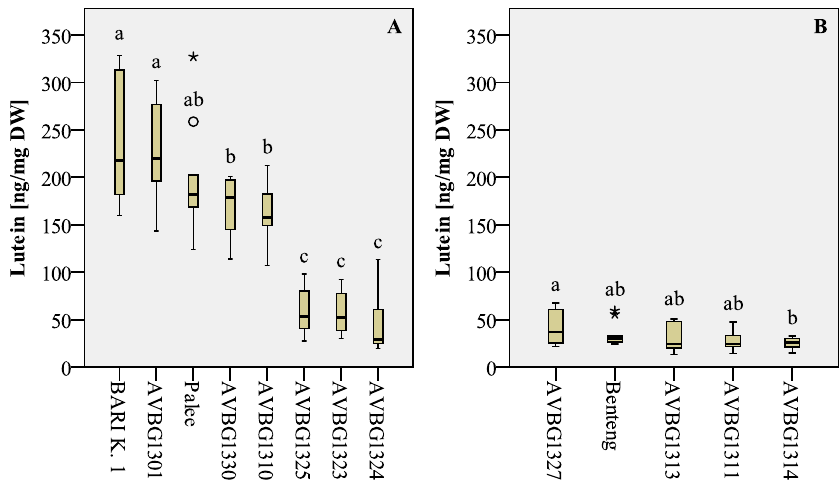
Fig. 5: Lutein contents in eight South Asian type (A) and five Southeast Asian (B) type bitter gourd entries cultivated in a greenhouse in Karlsruhe, Germany. Plots with same letters are not significantly different (P > 0.05). Stars stand for extreme values, open circles for outliers. BARI K. 1 = ‘BARI Karella 1’. 10 fruits per